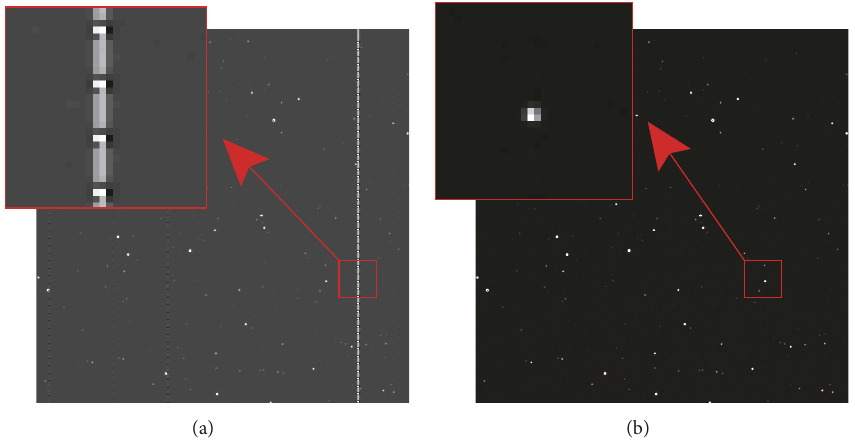
Figure 5: The final image restored using the proposed method.